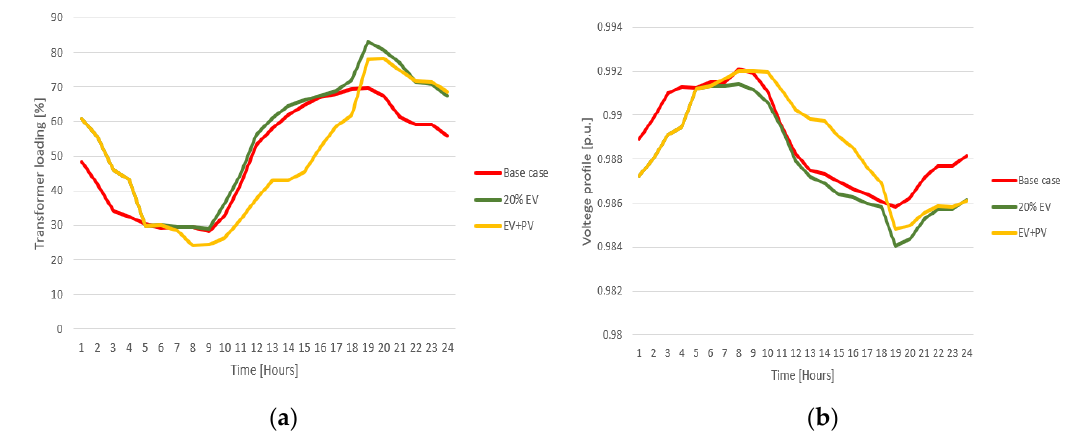
Figure 13. Comparison of rural ( a ) transformer loadings and ( b ) most loaded feeder voltage profiles with 20% EV penetration.